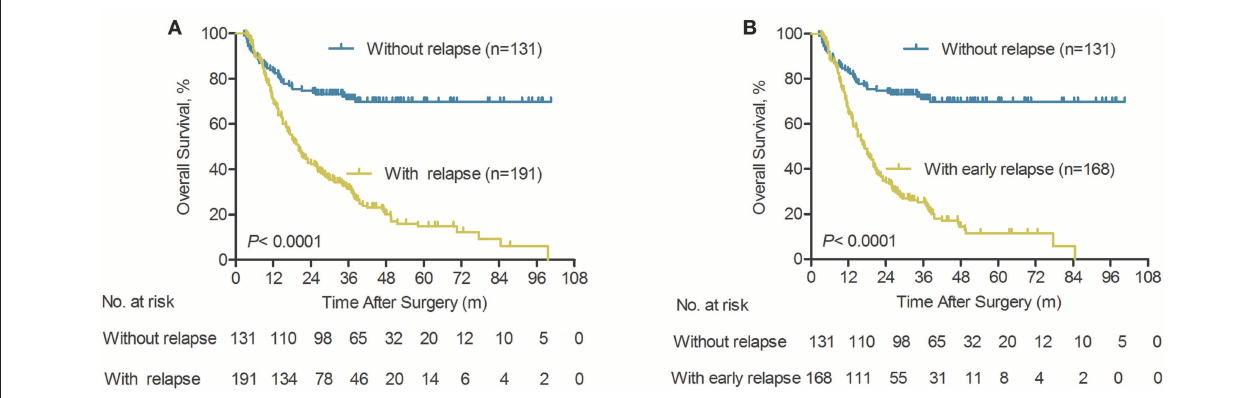
FIGURE 2 | Overall survival of patients according to the type of relapse after initial surgery for ICC. (A) Overall survival curves of ICC patients with relapse and without relapse ( n = 322), P < 0.0001 (log-rank test). (B) Overall survival curves of ICC patients with early relapse and without relapse ( n = 299), P < 0.0001 (log-rank test).